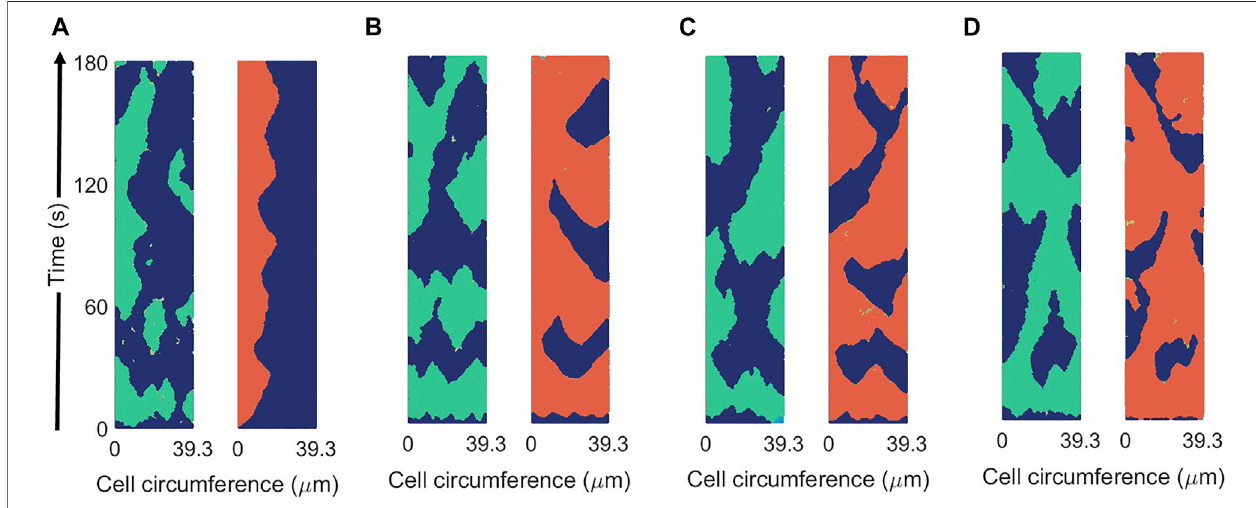
FIGURE 10| Spatio-temporal plots ofR (in green)and P(in red) for different values ofthe coupling parameter between R and P: k 13 = 0.1 s − 1 (A) , k 13 = 0.5 s − 1 (B) , k 13 = 1 s − 1 (C) , and k 13 = 2 s − 1 (D) in the new mass-conserved model. Results are for a fi xed values of σ R = 0.04 and σ P =